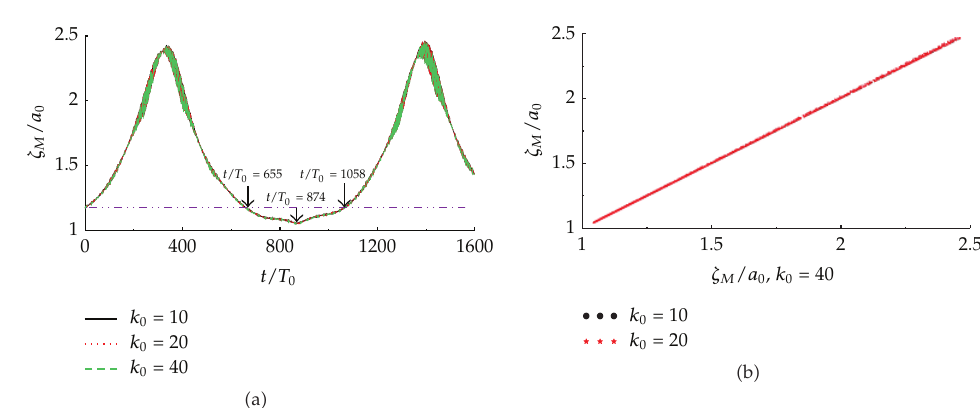
Figure 2: The maximum wave crest histories (cid:2) a (cid:3) and scatter diagram (cid:2) b (cid:3) of Stokes-modulated wave train for ε 0 (cid:7) 0.05, r 1 (cid:7) 0.1 with di ff erent k 0 (cid:7) 10, 20 and